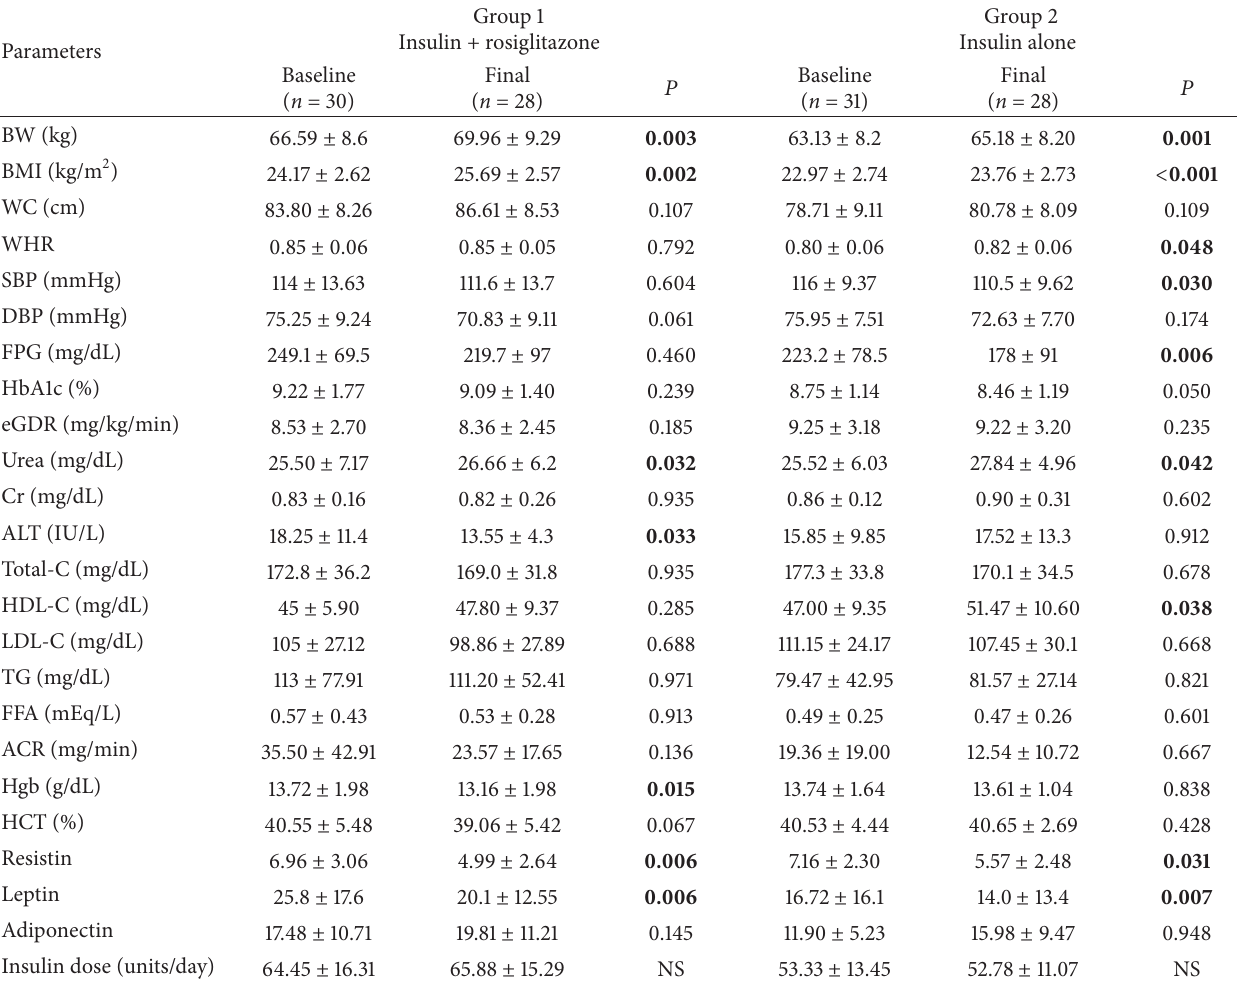
Table 2: Comparison between the baseline and final (week 16) values for each group.